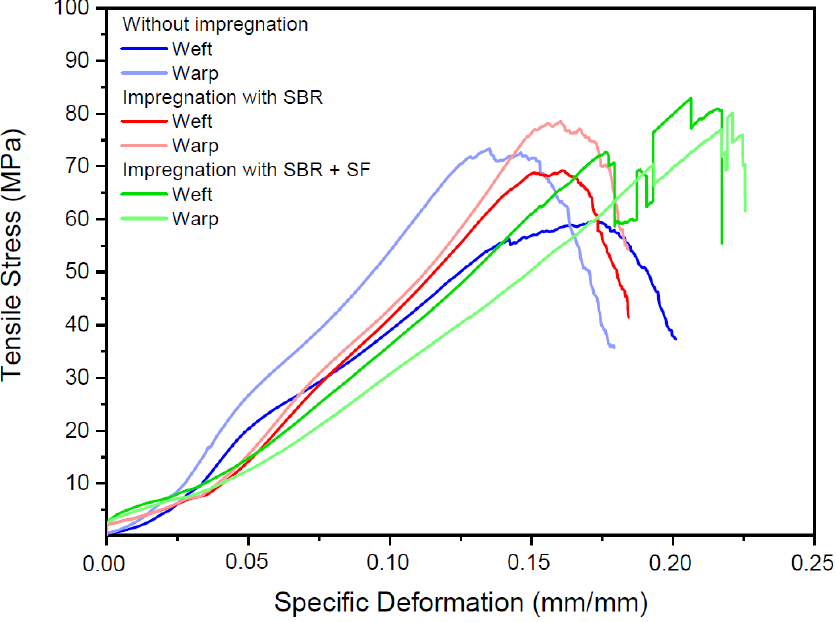
Figure 7. Stress–deformation curves along the weft and warp of polyester samples without treatment and with impregnation.